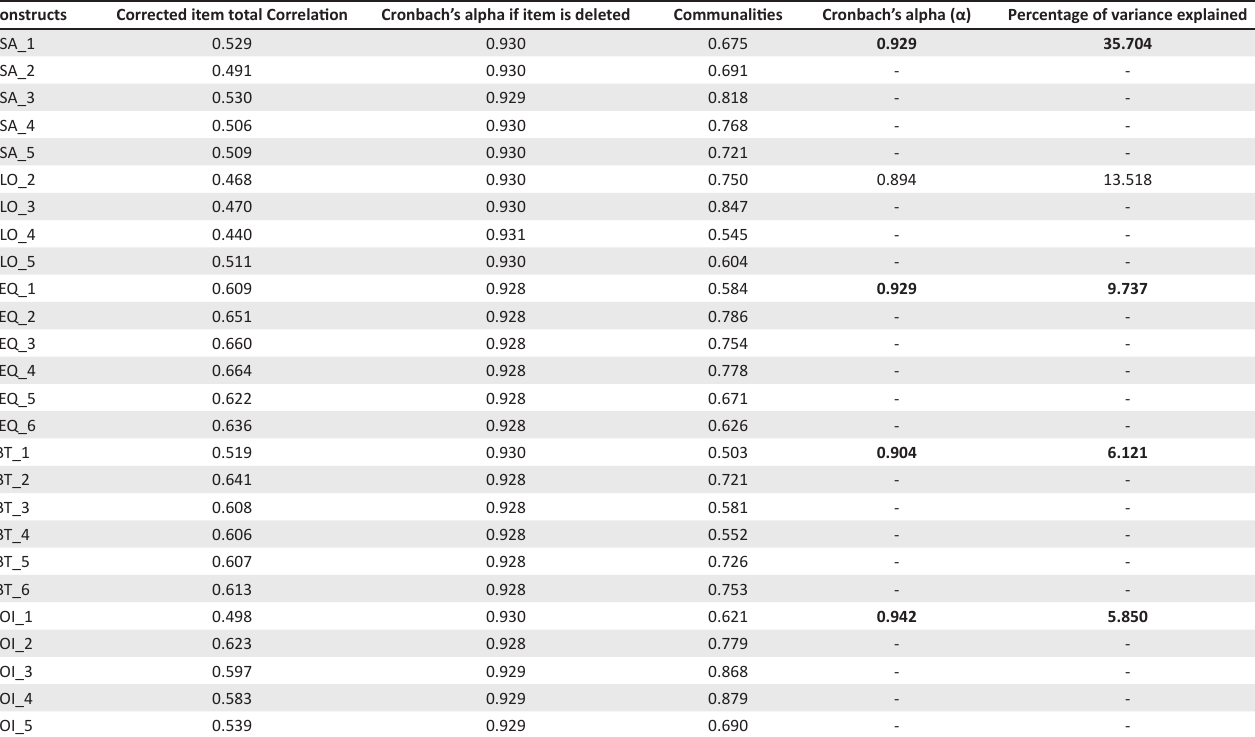
TABLE 6: Rest scores, Cronbach’s alpha and explained variation of factor loadings.